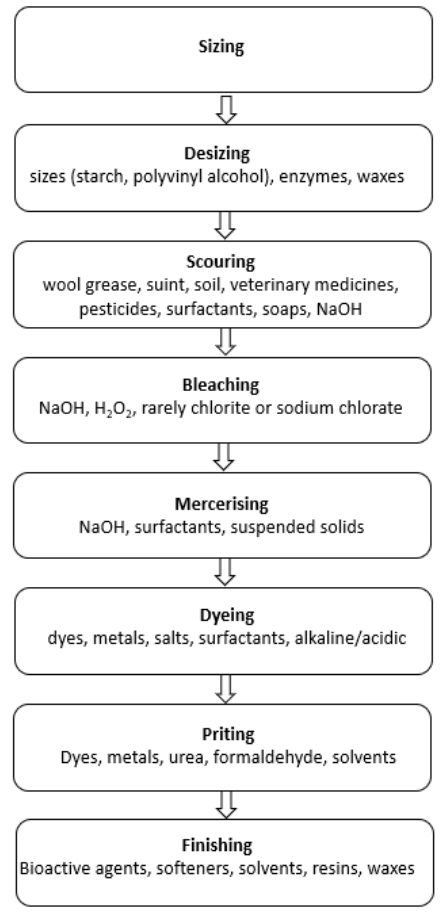
Figure 1. The most common pollutants generated in wet processes [14,21,26].